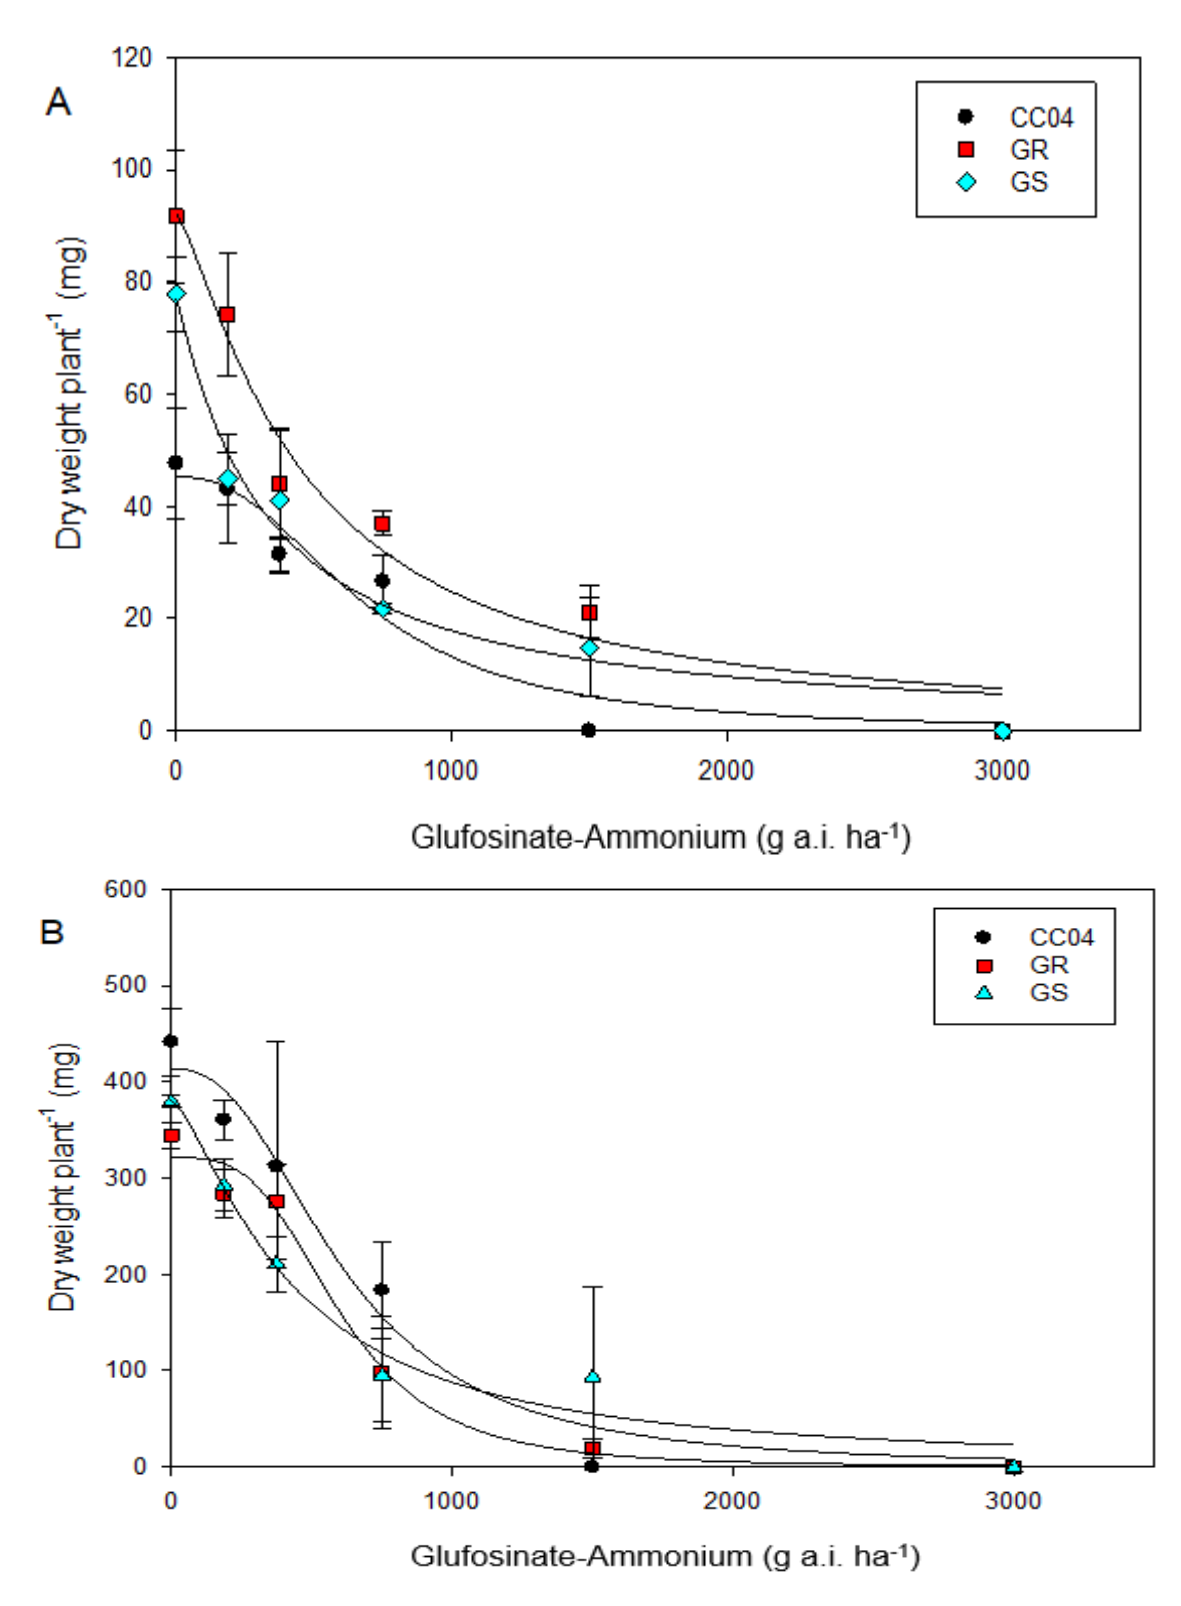
Figure 8. Dry weight per plant of three Lolium rigidum populations (CC04, GR, and GS) to six rates of glufosinate in ( A ) 2019 and ( B ) 2021. Data are presented as the average dry weight per plant and error bars represent the standard error of the mean.